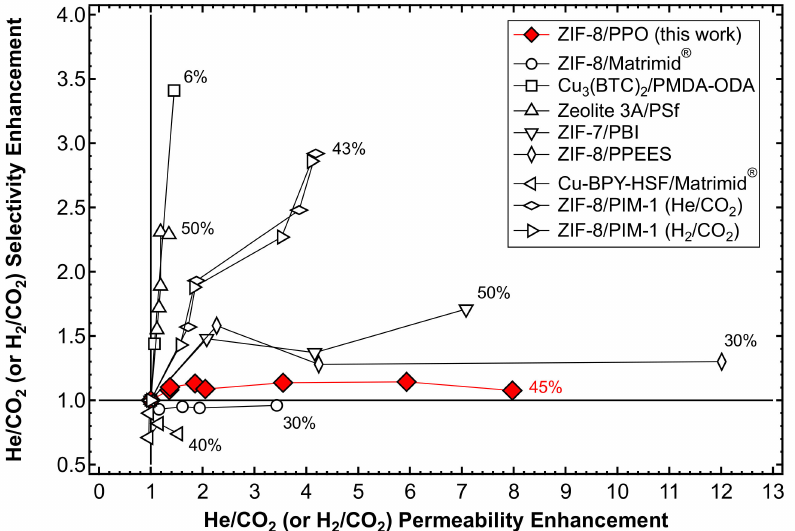
Figure 25. E ff ect of the addition of size-selective fillers on the He (or H 2 ) permeability and He(or H 2 ) / CO 2 selectivity of a series of glassy polymers with respect to the pure polymer matrix. The maximum loading achieved by each MMM is represented next to each series of data. Results from references